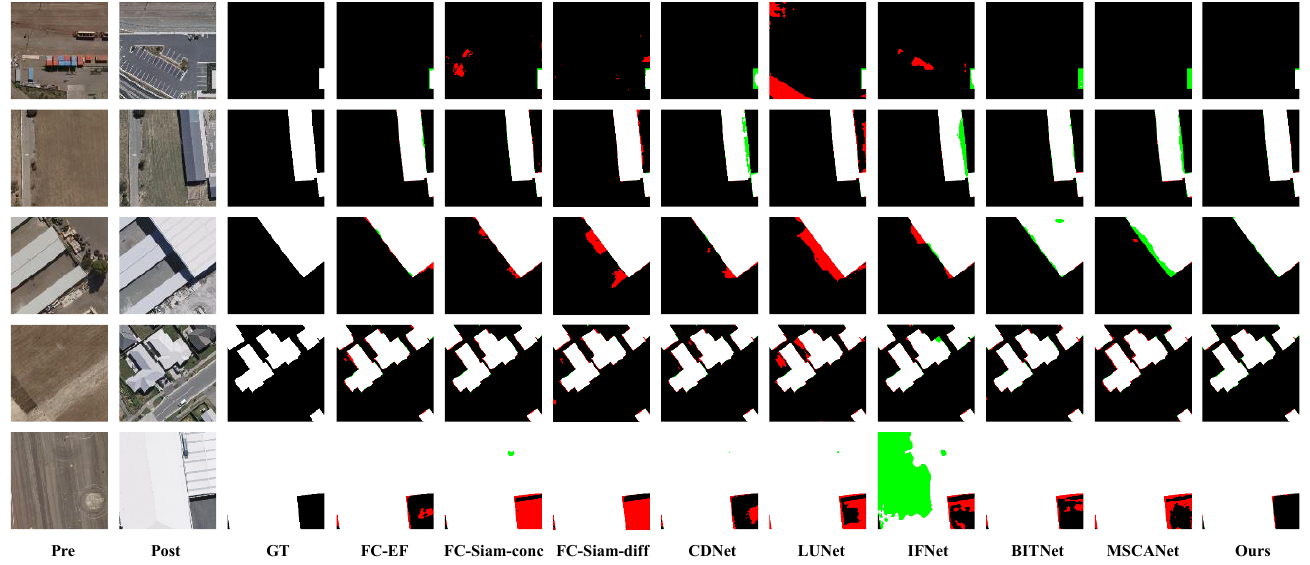
Figure 9. Visualization results of different CD methods in five scenarios from the WHU-CD dataset. We plot the FP in red and the FN in green in order to better compare the CD results.